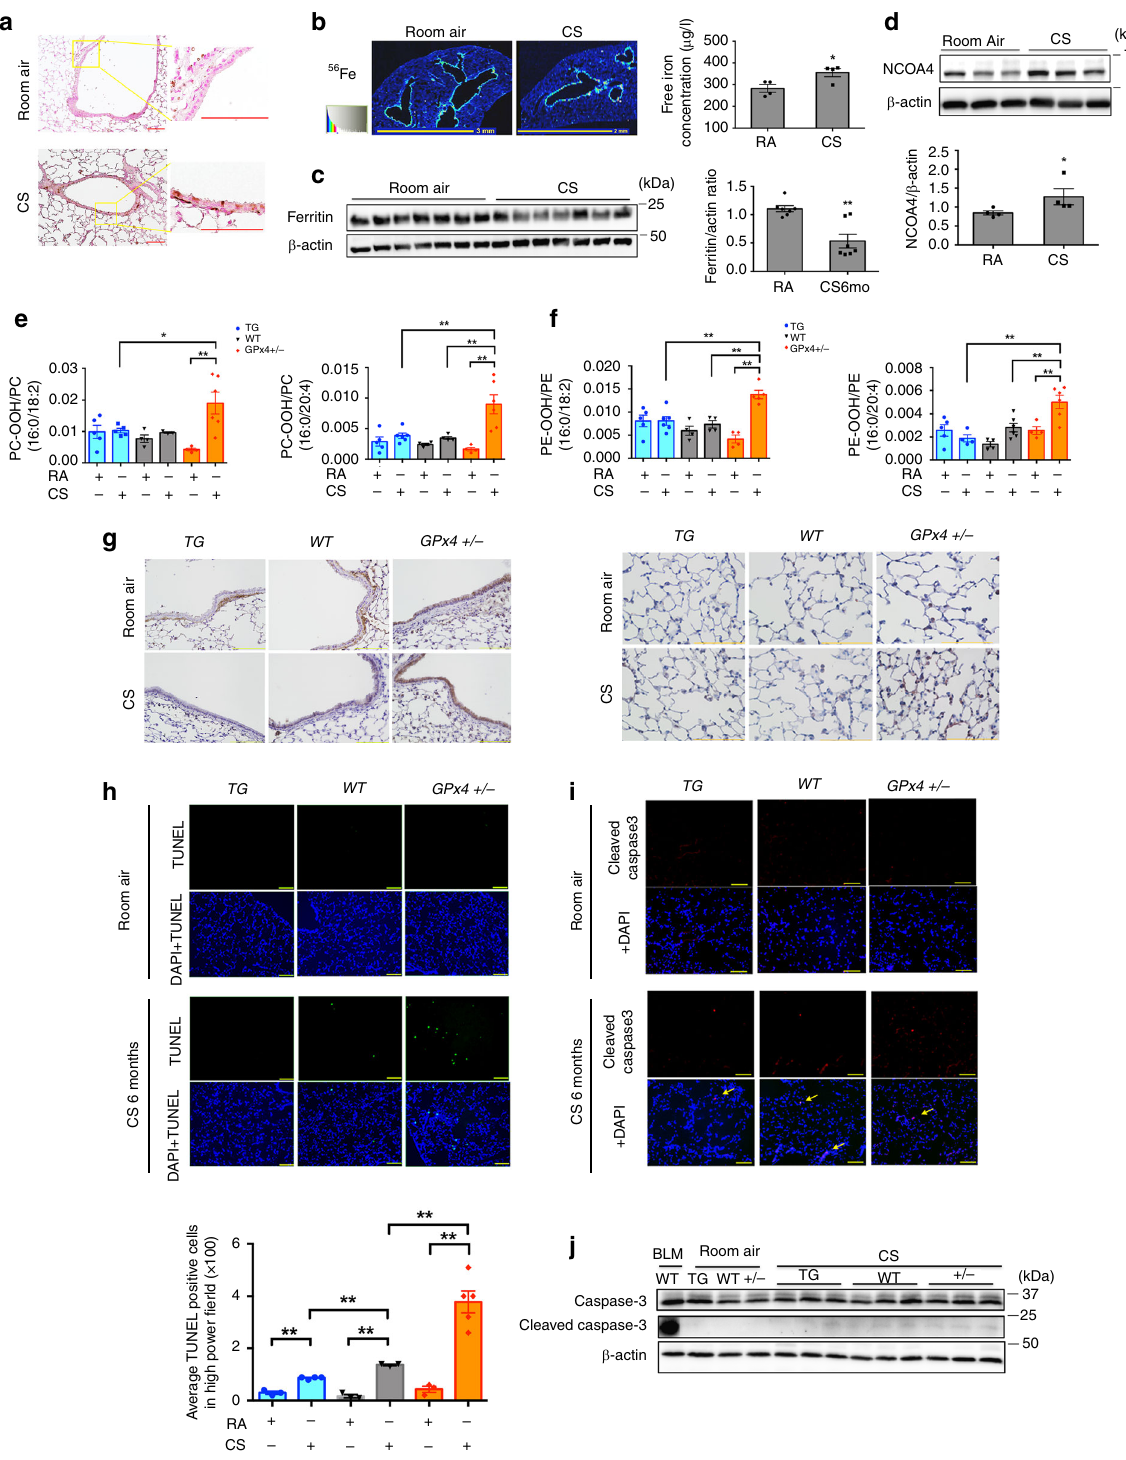
Involvement of ferroptosis in human COPD lung . To elucidate the potential involvement of GPx4 in COPD pathogenesis, we evaluated GPx4 expression levels in human bronchial epithelial cells isolated from never smoker ( n = 6), smoker non-COPD ( n = 6), and COPD patient lung ( n = 7). Western blotting demonstrated that GPx4 expression was signi fi cantly lower in HBECs from COPD lungs than in never smoker ’ s and non COPD smoker ’ s lungs (Fig. 5a). Furthermore, GPx4 expression